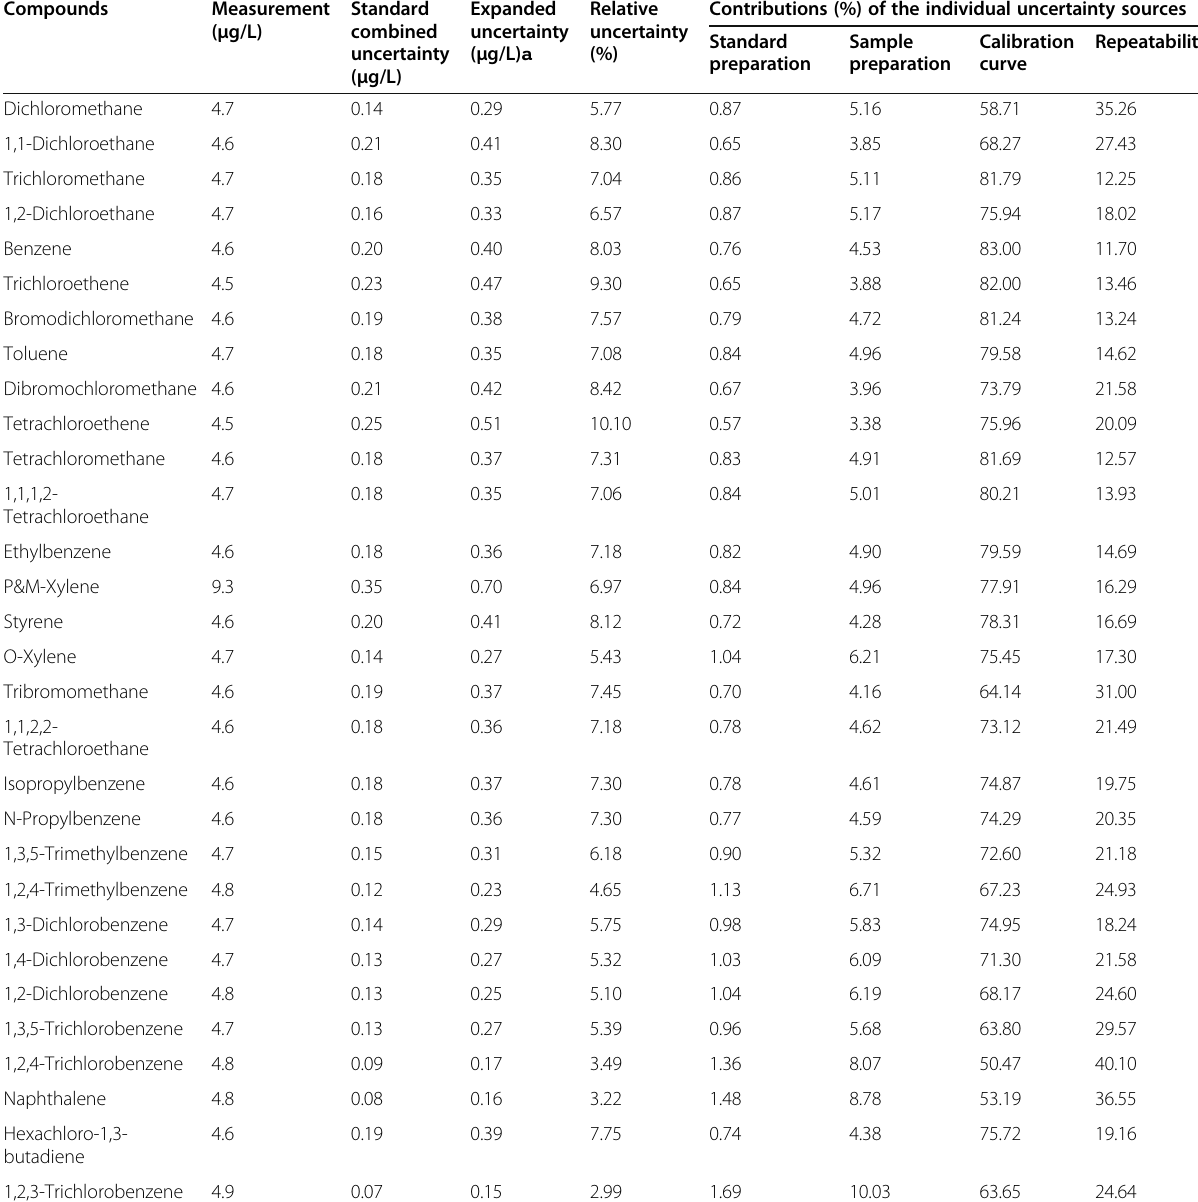
Table 5 Measurement uncertainty study of investigated VOCs at 5 μ g/L Compounds Measurement